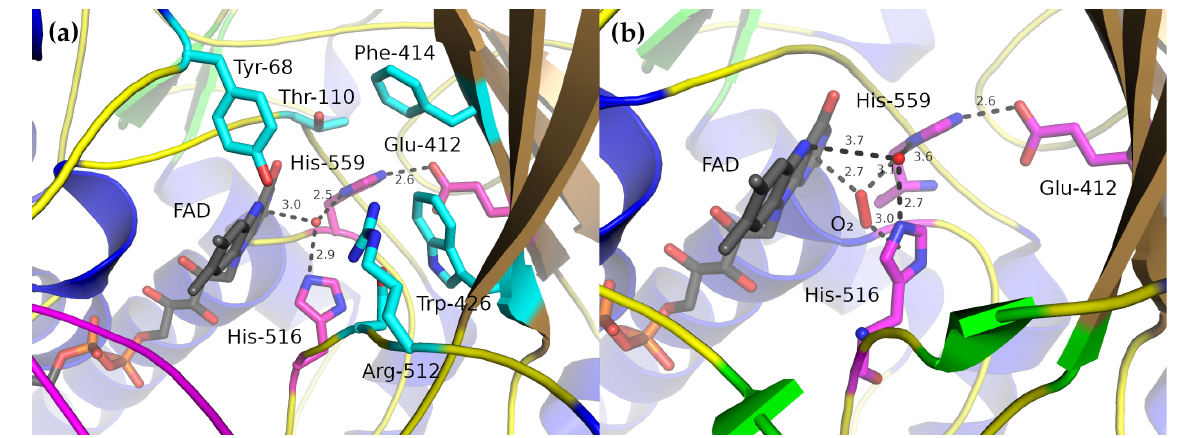
Figure 3. The active site of A. niger GOx. ( a ) The active site of the oxidized form of the enzyme in the absence of any substrate. The residues potentially important for catalytic activity are colored magenta; those which are thought to be involved in binding β - D -glucose are colored cyan. The water molecule near the center is thought to indicate the approximate location of the β - D -glucose O1 hydroxyl in the substrate-bound conformation. PDB structure 1 CF 3 [10] is shown. ( b ) The active site of an engineered GOx mutant showing an O 2 molecule bound to the active site (PDB structure 5 NIT from Petrovi ´c et al. [12]).